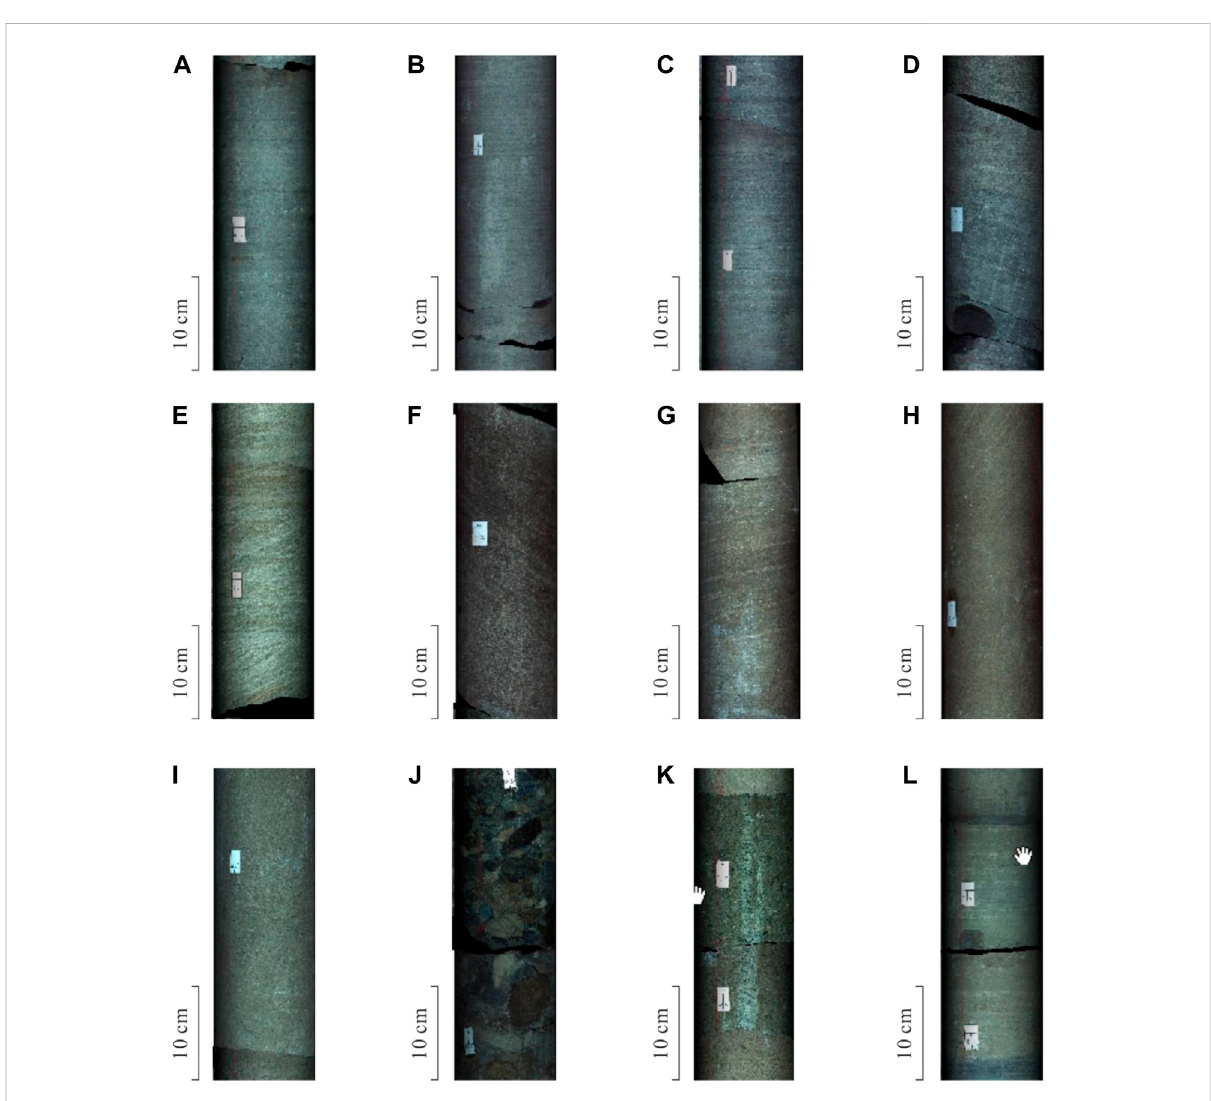
FIGURE 3 Typical core photographs of the Shangwuerhe Formation in the Fukang Sag Junggar Basin. (A) Argillaceous siltstone, Fu48, 4489.5 – 4489.8 m, and P 3 w; (B) Silty fi ne sandstone, Fu47, 5035.6 – 5035.9 m, and P 3 w; (C) Sandy mudstone and silty fi ne sandstone, Fu47, 5035.2 – 5035.5 m, and P 3 w; (D) Silty mudstone, KT2, 4849.7 – 4850.0 m, and P 3 w; (E) Fine sandstone, KT1, 5086.6 – 5086.9 m, and P 3 w; (F) Medium-grained sandstone, KT2, 4601.6 – 4601.9 m, and P 3 w; (G) Gravelly fi ne sandstone, KT5, 5969.1 – 5969.5 m, and P 3 w; (H) Fine sandstone, Fu48, 4531.1 – 4531.4 m, and P 3 w; (I) Gravelly coarse sandstone, Fu47, 5038.0 – 5038.3 m, and P 3 w; (J) Conglomerate, Fu47, 5140.7 – 5141.0 m, and P 3 w; (K) Glutenite, Fu48, 4533.7 – 4534.0 m, and P 3 w; and (L) Silty fi ne sandstone and mudstone, Fu48, 4493.2 – 4493.5 m, and P 3